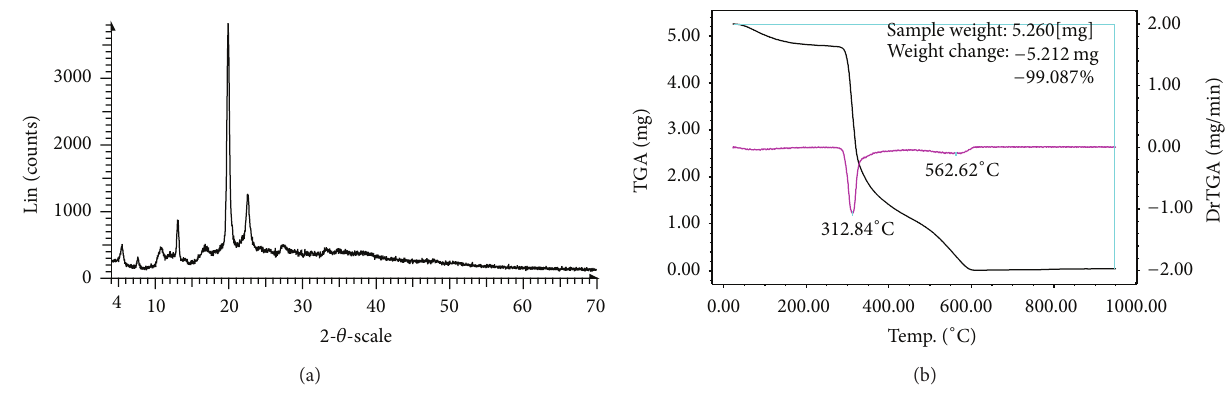
Figure 3: (a) XRD pattern of PPR; (b) TGA of PPR.